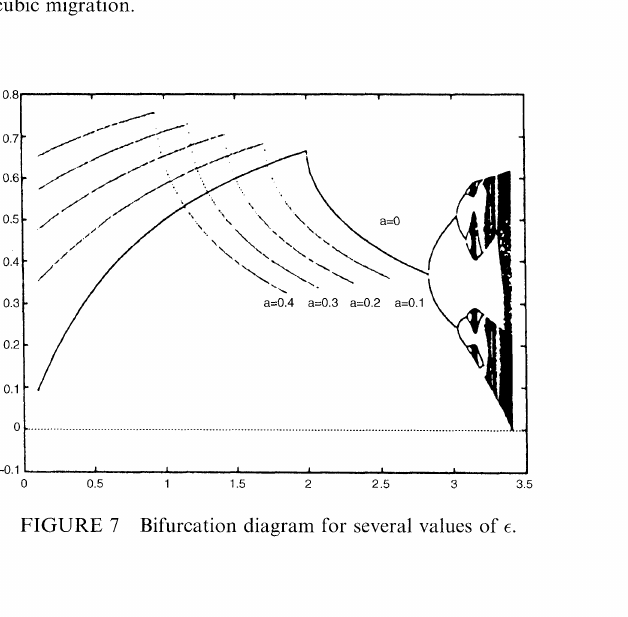
FIGURE 7 Bifurcation diagram for several values of